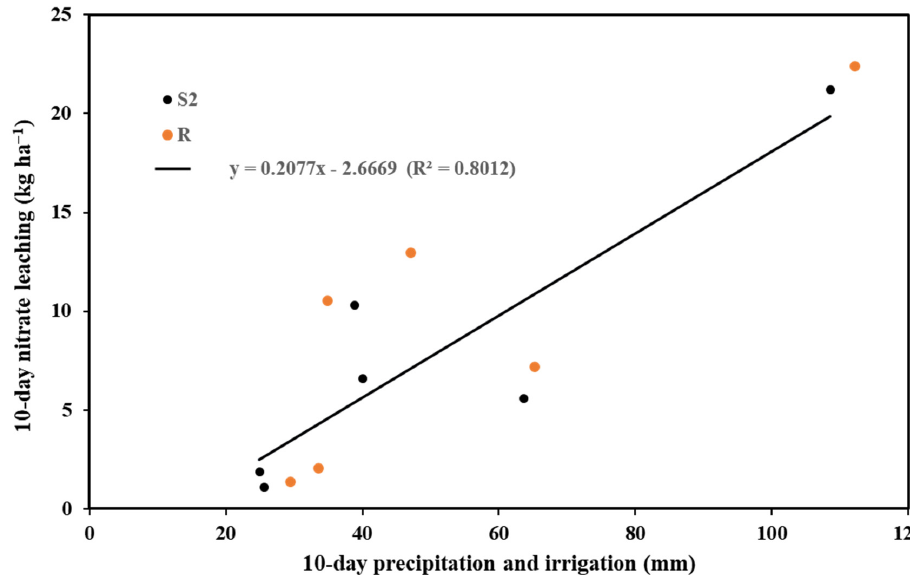
Figure 14. Linear regression between 10-day precipitation plus irrigation and 10-day nitrate leaching at 2 m soil depth in second season.